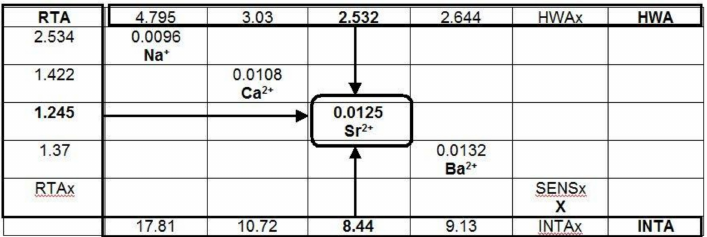
Figure A3. A schematic presentation of the automatic identification process. Parameters RTA, HWA and INTA are used to identify the metal ion. Sensitivity parameter SENS, defined as SENS = c[mM]/INT[a.u.], where c is the concentration of the metal ion [mM], and INT – the integral intensity of the signal. SENS is calculated during the calibration, together with other parameters, RTA, HWA and INTA, and used to evaluate the concentration of the analyzed metal ion with the aid of the integral intensity, INT, of the measured signal, e.g., for metal X, c x = SENS x × INT x